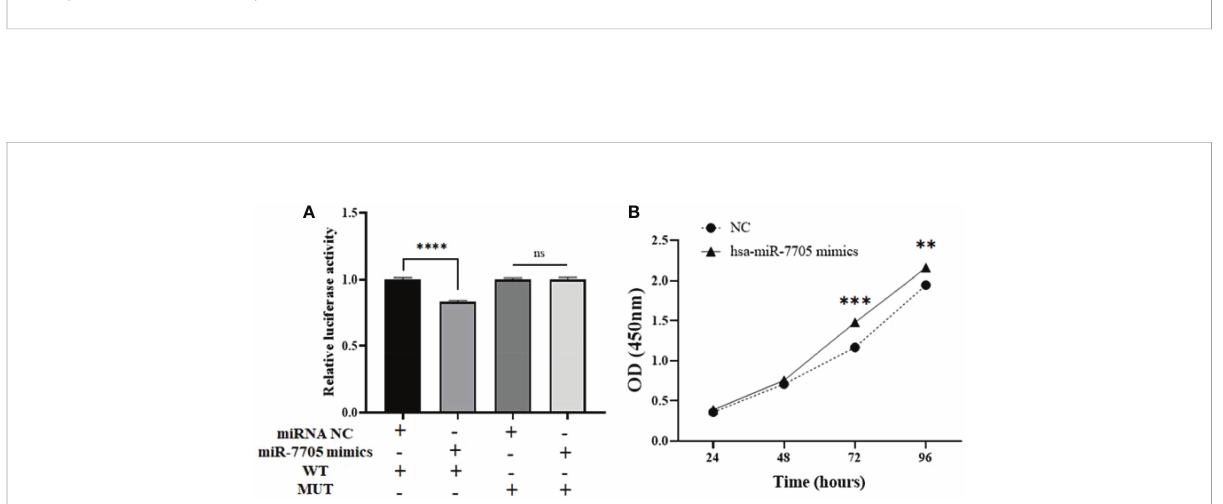
FIGURE 6 Expression of hsa-miR-7705 in gastric cancer cells and gastric cancer tissues. (A) Expression of has-miR-7705 in gastric cancer cells. Independent samples t -test (two-tailed); ns, not signi fi cant; * p < 0.05, n = 3. (B) Expression of hsa-miR-7705 in gastric cancer tissues. Paired sample t -test (two-tailed); * p < 0.05, n =